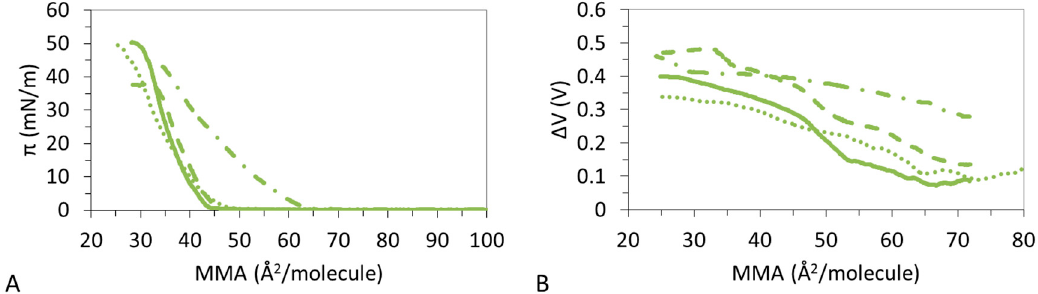
Figure 8. E ff ect of electrolyte on DPPC:DPPS:CHOL-70 monolayers. ( A ) π - A and ( B ) ∆ V – A isotherms. 15 mM NaCl (straight line), 5 mM CaCl 2 (dashed line), 5 mM MgCl 2 (dash-dotted line), 2.5 mM LaCl 3 (dotted line). Curves replotted from Figures 1 and 2.